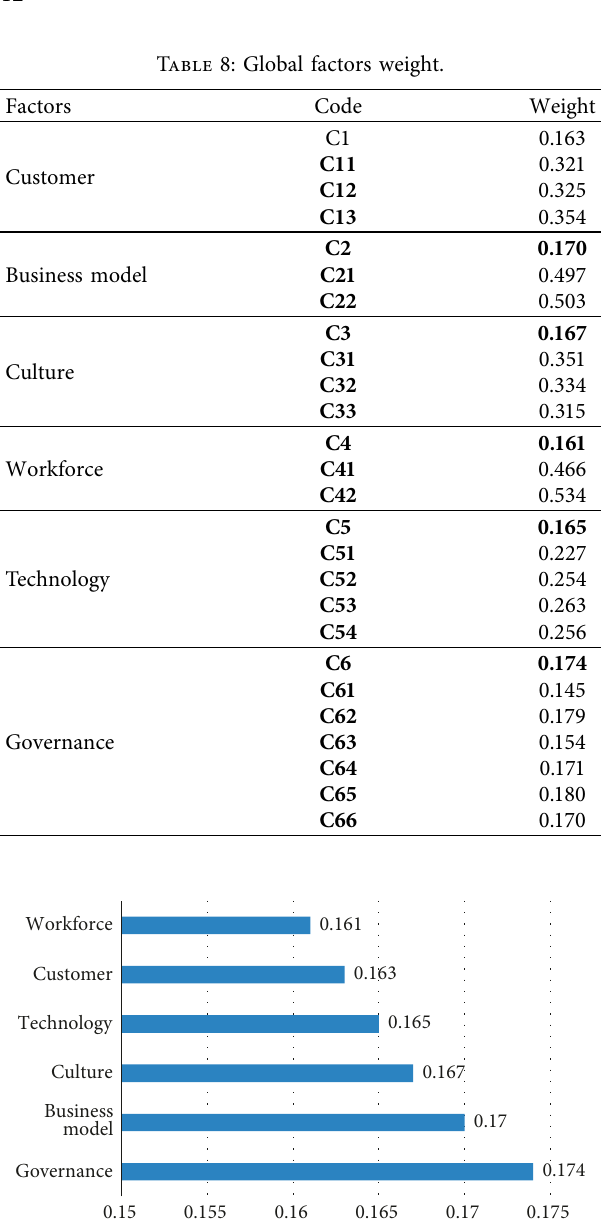
Figure 5: The weight of the main